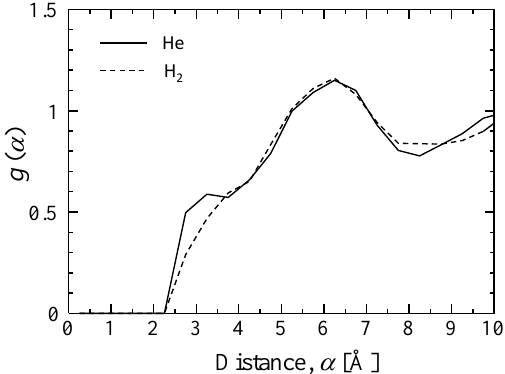
Figure 8. Radial distribution function of sorption sites for probing helium and hydrogen.